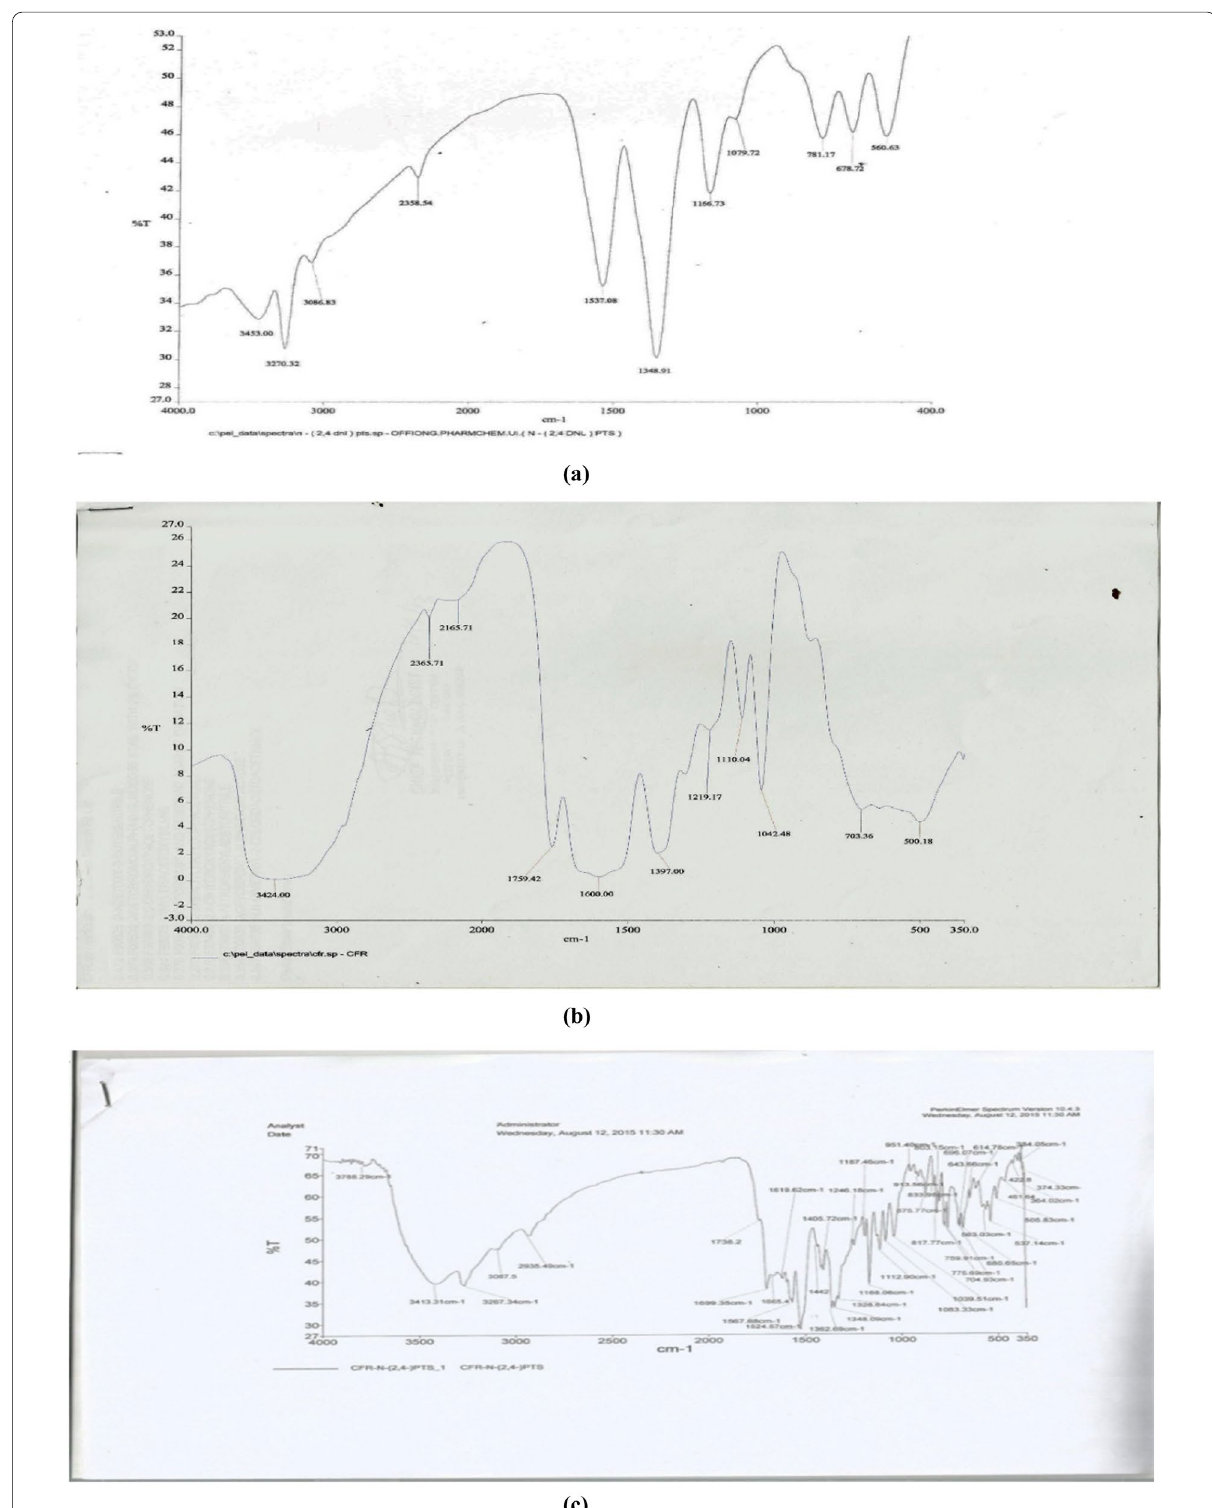
Fig. 6 a The infrared spectrum of N-(2,4-DN1NL) PTS, b the infrared spectrum of CFR, c the infrared spectrum of CFR-N-(2,4-DN1NL) PTS